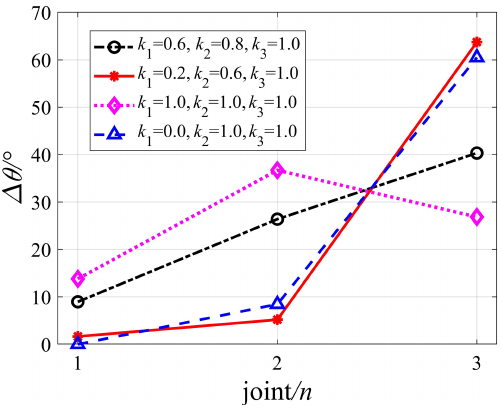
Figure 10. Variations of joint motions with different motion prior-